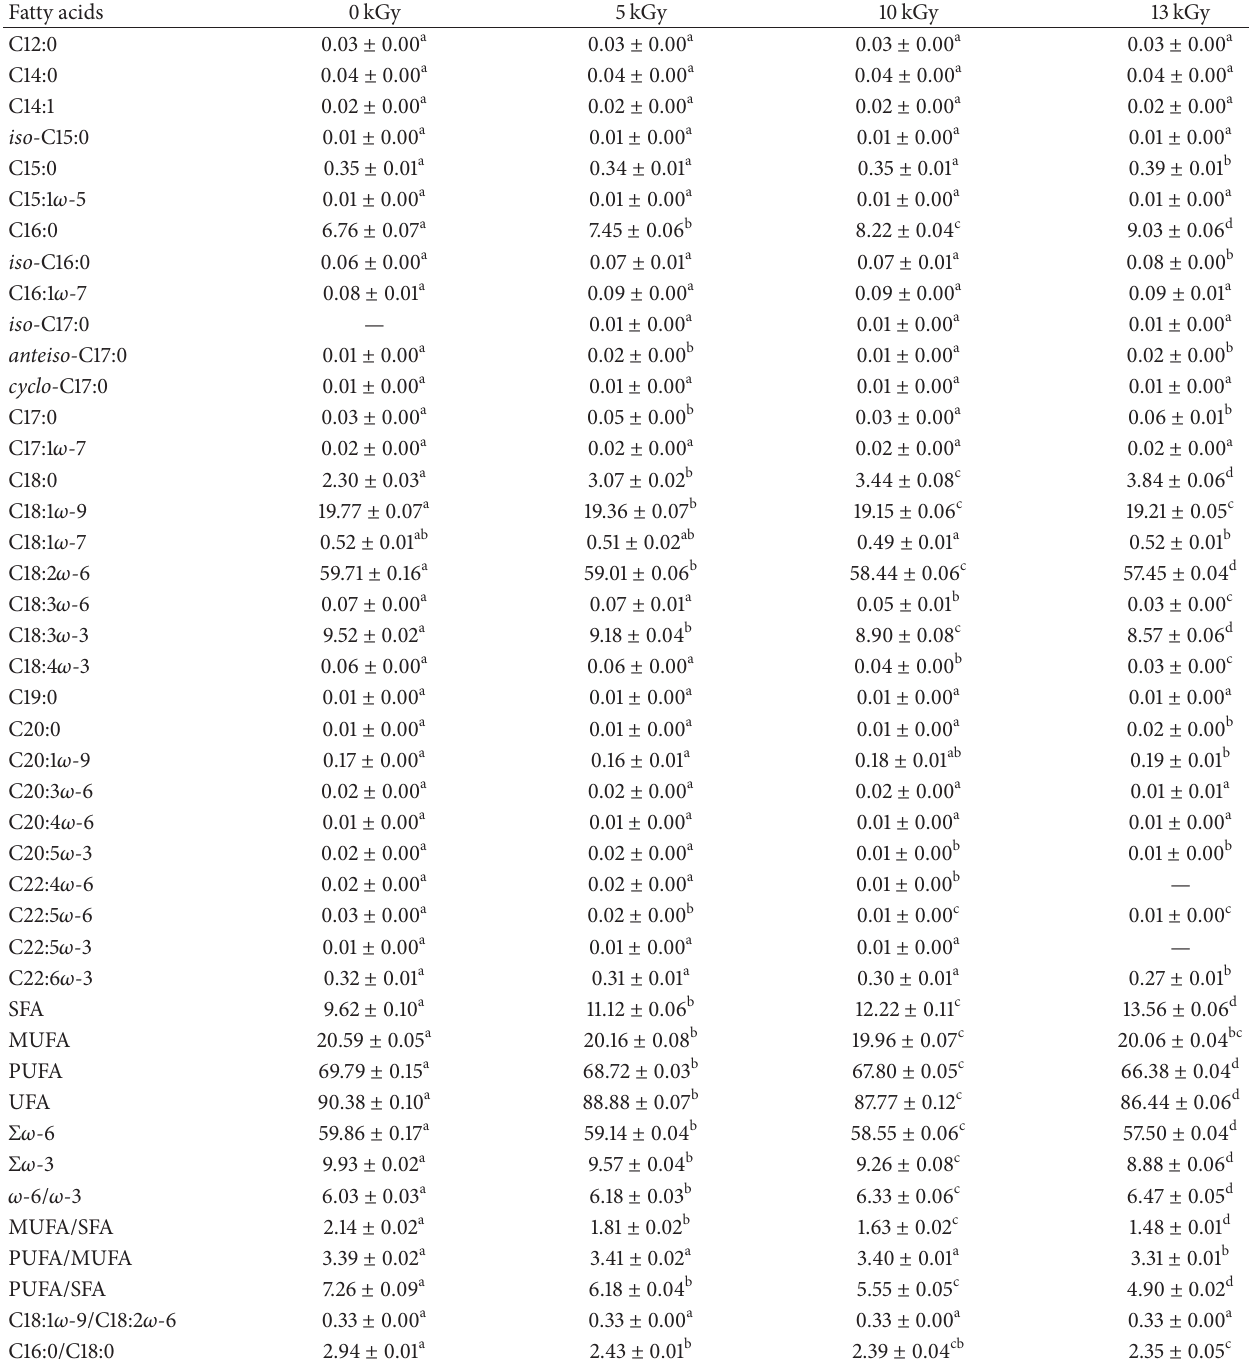
Table 1: Fatty acids composition % of (Total Fatty Acids) TFA in total lipids of non-irradiated and irradiated walnuts packaged in atmospheric